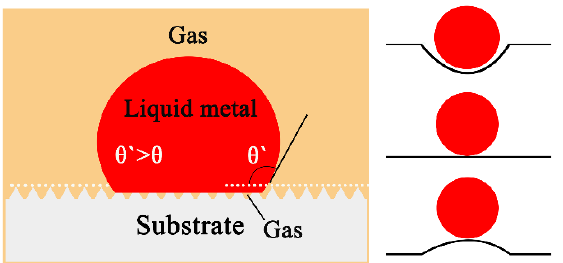
Figure 12. Schematic configurations of a sessile drop resting on the substrate with rough surfaces in the case of θ > 90°.